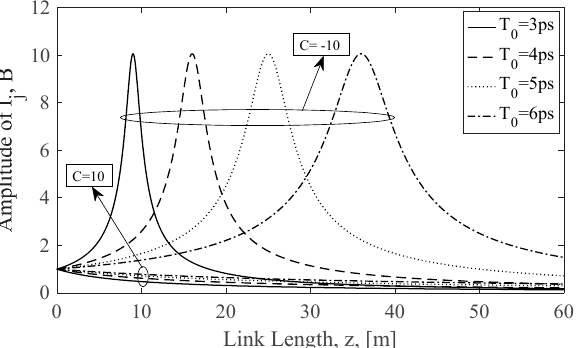
Figure 1. Amplitude of the optical pulse, i.e., B parameter, as a function of the propagation distance.